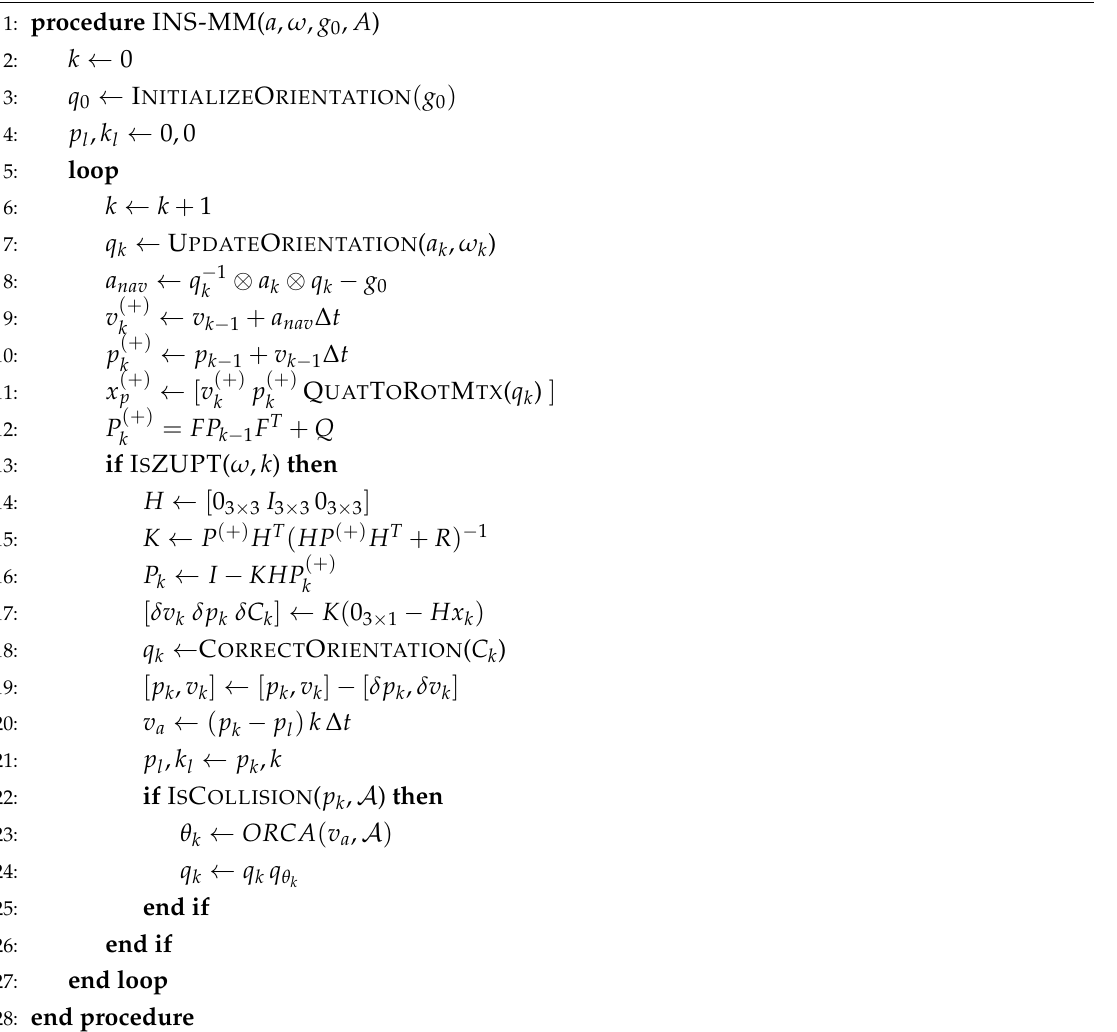
Algorithm 1 Pseudocode for the inertial positioning system with zero-velocity updates and collision avoidance velocity map